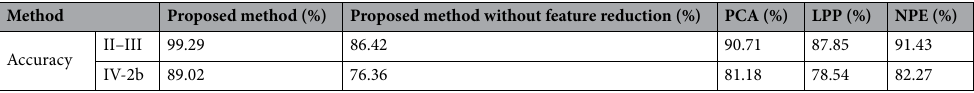
Table 12. Accuracy of different feature reduction